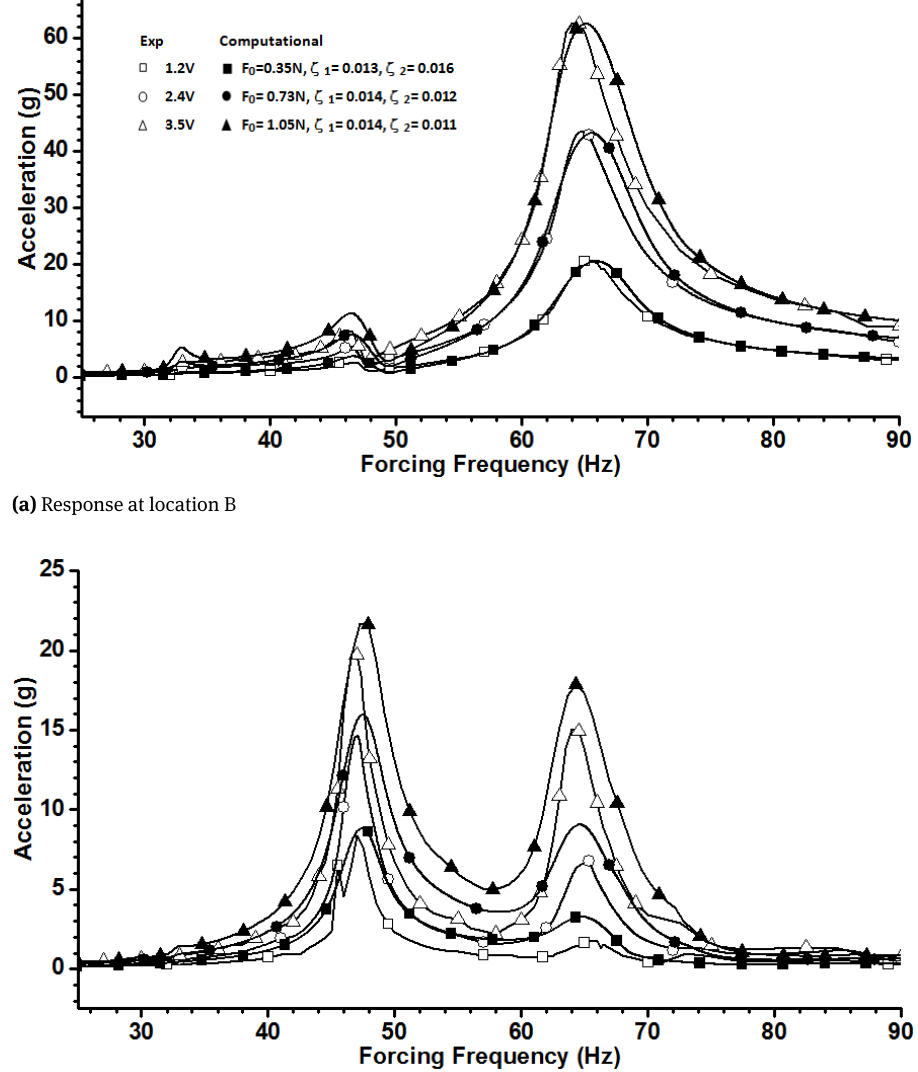
Figure 3: Acceleration versus forcing frequency curves of curved beam (span angle = 80 ∘ ) excited at location B with excitation amplitudes of 1.2, 2.4 and 3.5 Volts: (a) Response at B, (b) Response at A.